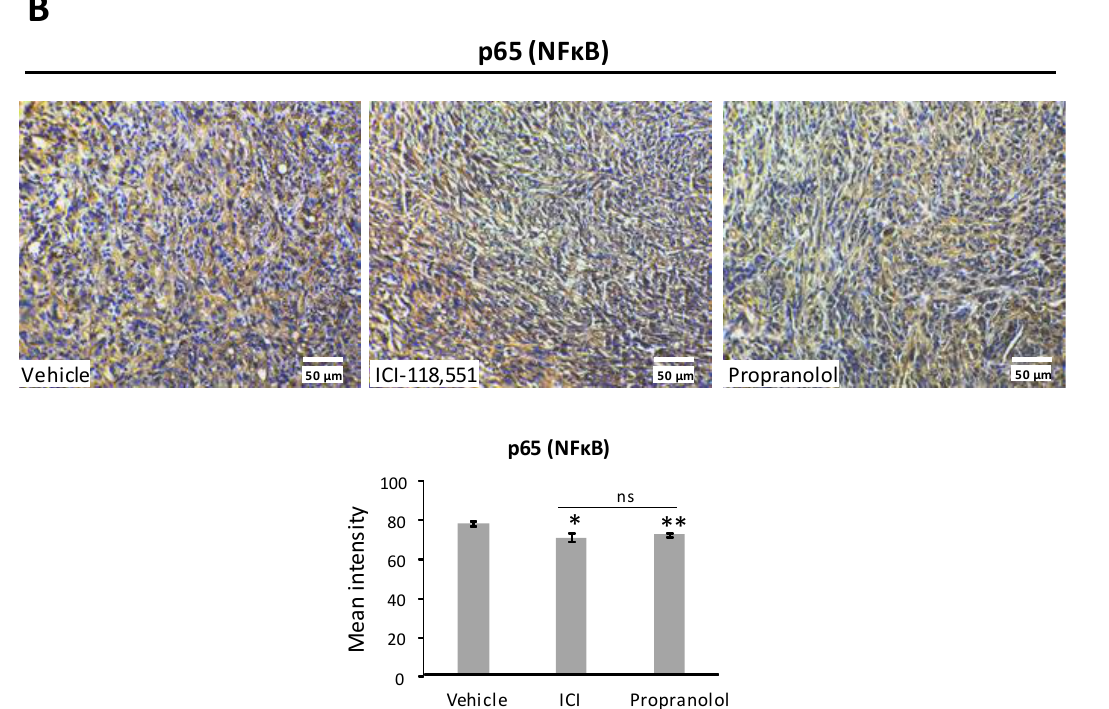
Figure 5. Immunohistochemical detection and quantification of Glutathione peroxidase ( A ) and p65 (NFκB) ( B ) in the 786-O tumor xenografts treated with vehicle, propranolol, or ICI. Cell nuclei were